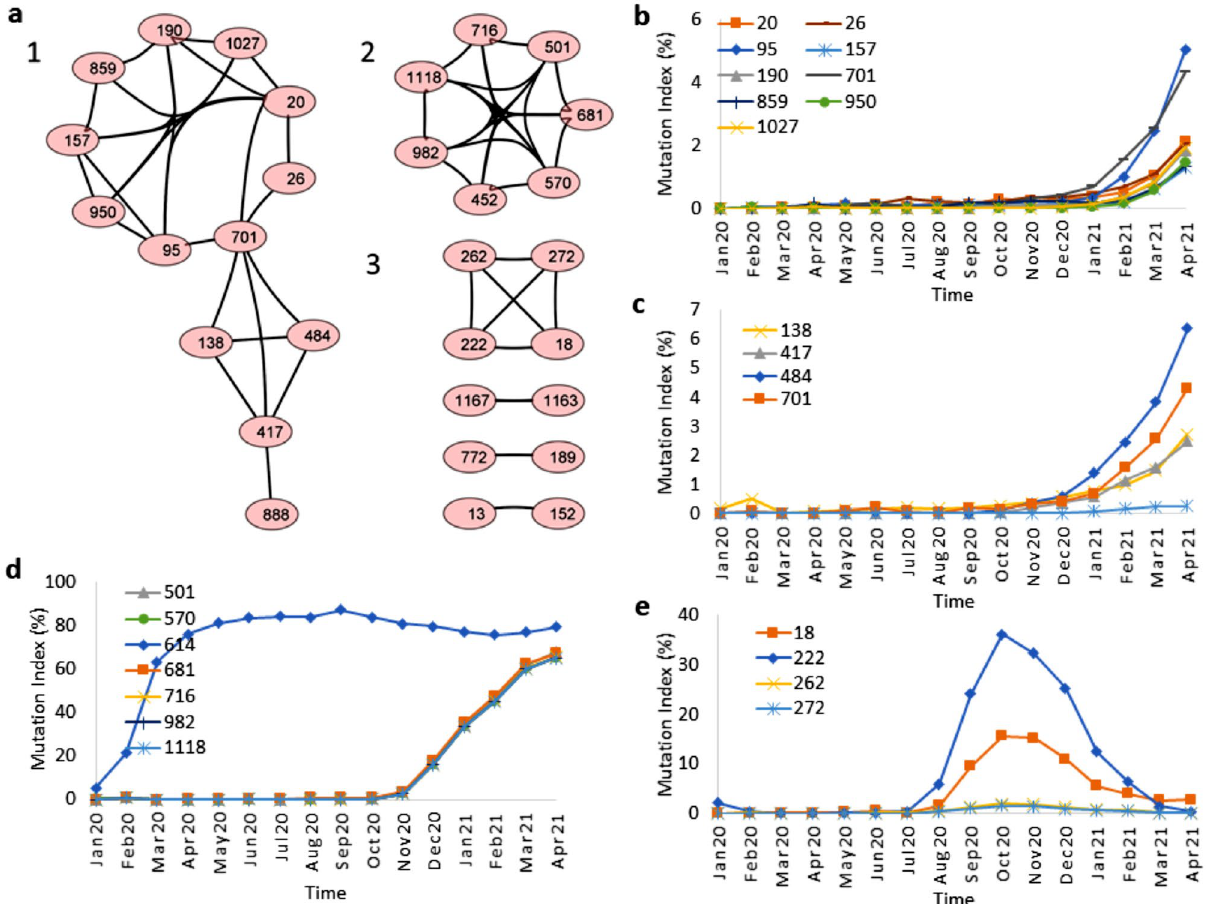
Figure 4. Evolution over 18 months of mutation signatures across all countries. ( a ) Three major clusters, marked as 1, 2 and 3, of mutations that each have a similar evolution profile. ( b ) and ( c ) Time evolution of mutations in cluster 1. These mutations have a low but increasing mutation index. ( d ) Mutations at residue positions in cluster 2 including the singular D614G mutation. These mutations are still present in April 2021with high frequencies. ( e ) Mutations from cluster 3. These mutations, with increasing presence from July 2020 to Nov 2020 and gradual decay after that, may have played a significant role during the second wave of